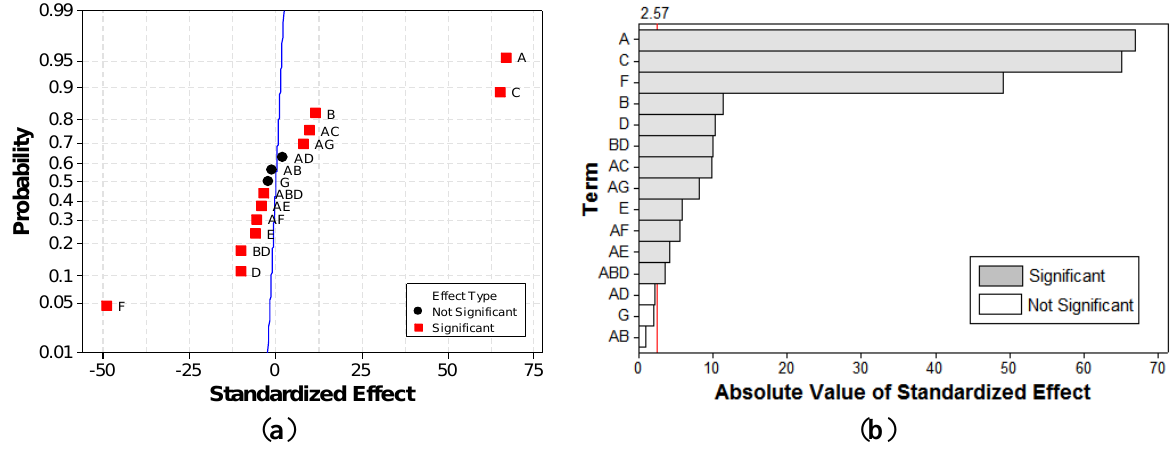
Figure 12. Normal plot of ( a ) the standardized effects; and ( b ) standardized Pareto chart for UEMD